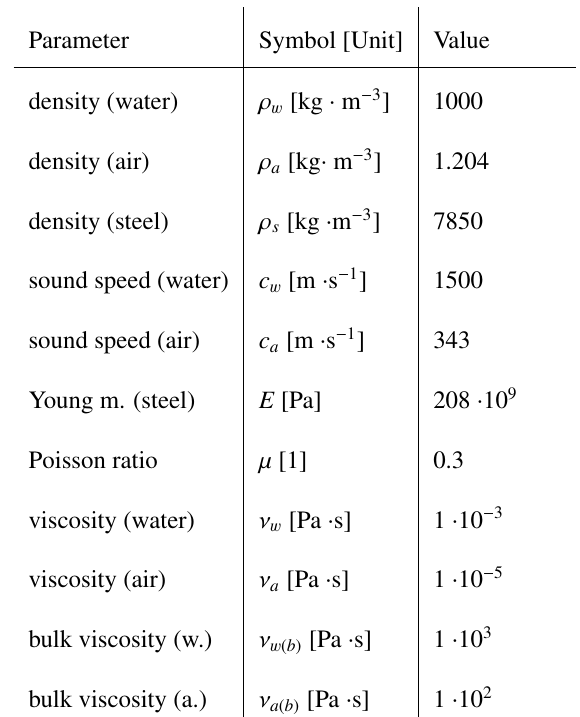
Table 2. Simulation parameter